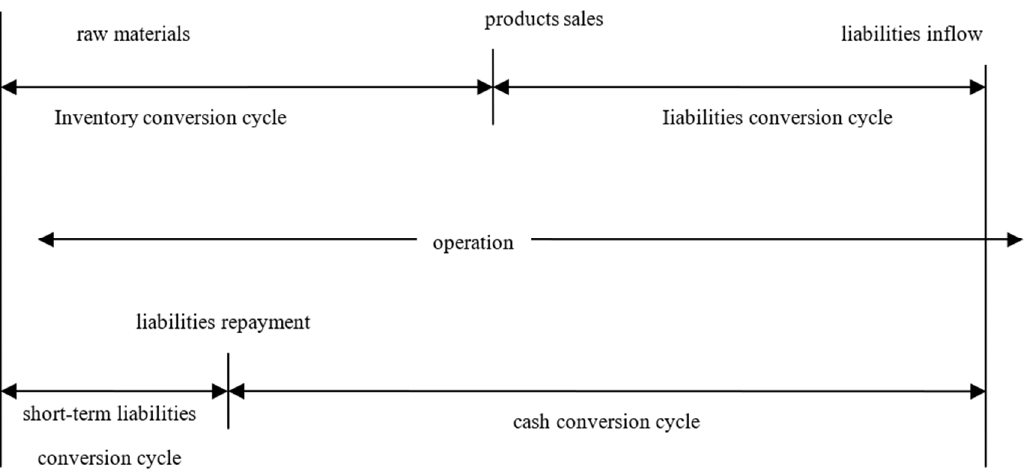
Figure 7. Operating and cash-conversion cycles.